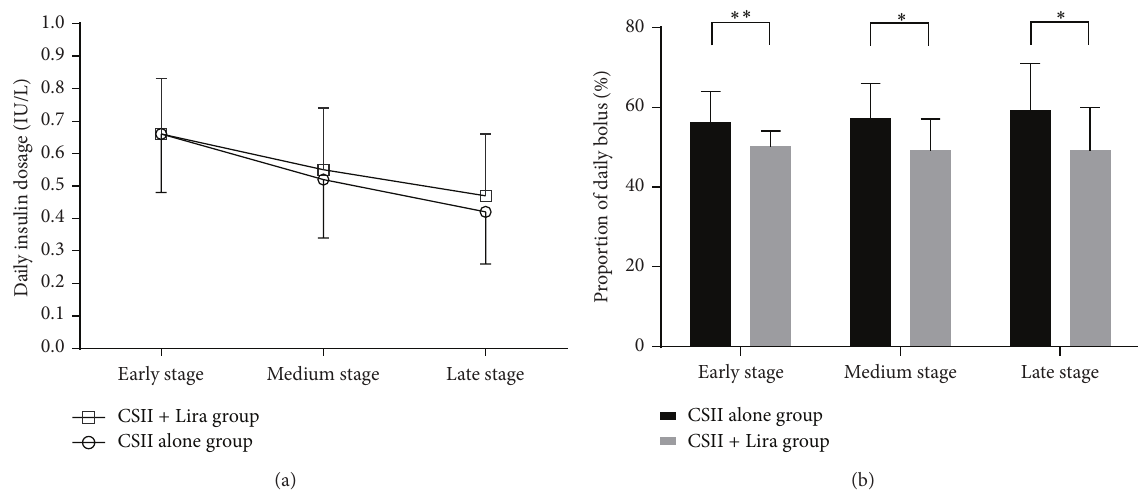
Figure 1: Daily insulin dosage and proportion of daily bolus of two groups. ((a) Daily insulin dosage, (b) proportion of daily bolus, ∗ 𝑃 < 0.05 , ∗∗ 𝑃 < 0.01 .)